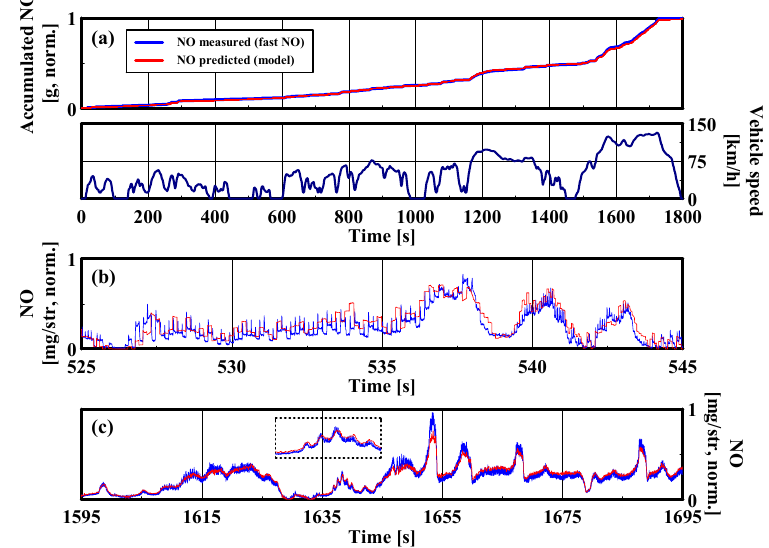
Figure 8. ( a ) The normalized cumulative mass of the NO and the velocity profile of the WLTC with respect to time; ( b ) Magnified time window to show the cycle-by-cycle estimated and measured real-time NO emissions in a portion of the WLTC (low phase); ( c ) Estimated and measured NO emissions mass vs. time history (extra-high phase), (red: model predicted, blue: fast NO analyzer measured).